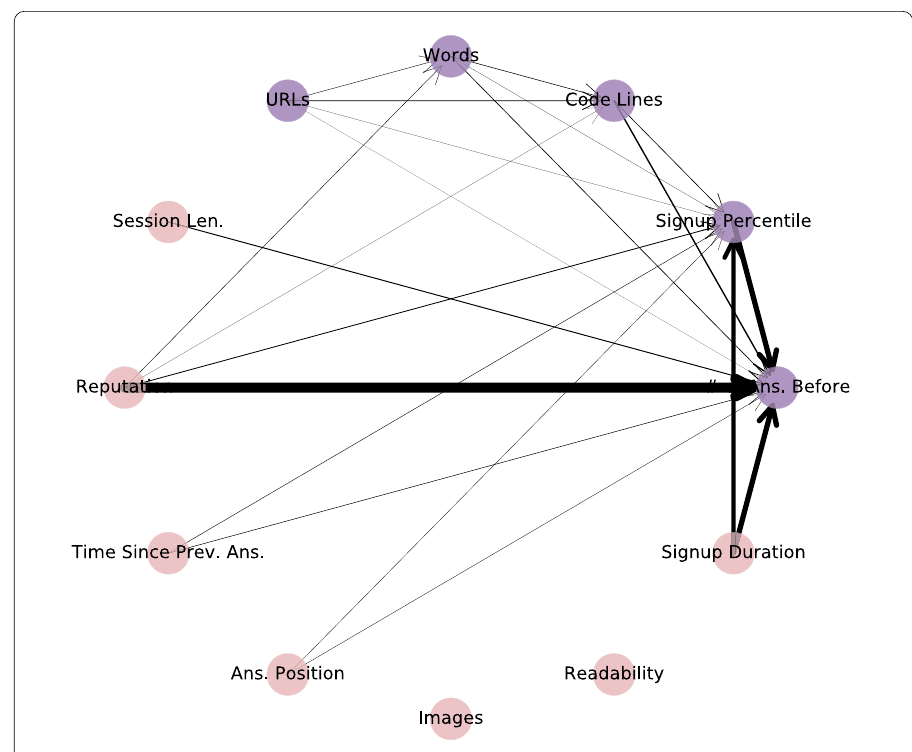
Figure 8 The feature network for Stack Exchange, showing the variation in the outcome from the features that have not been selected (pink) through the selected features (purple). Edge width is proportional to weights described in Sect. 3.2.1—the thicker a link between two features is, the more correlated they are